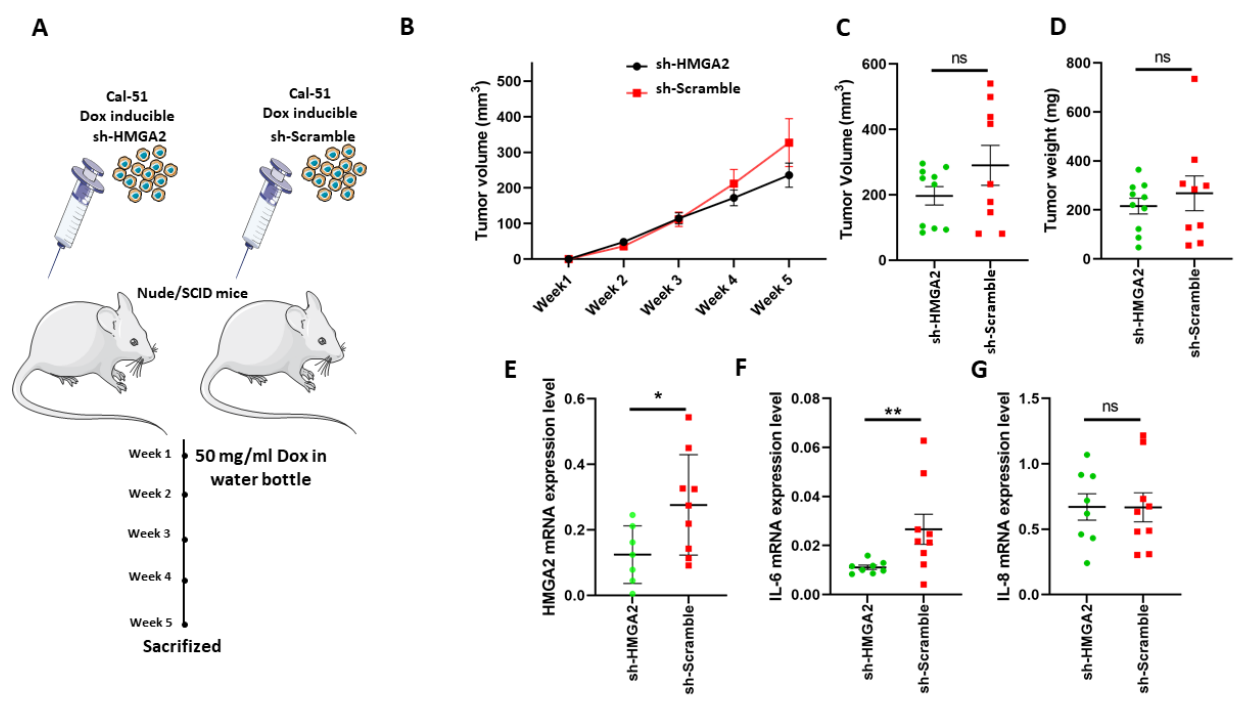
Figure 8. HMGA2 silencing decreased IL-6 expression in TNBC xenografts. Schematic illustration of an in vivo experiment with HMGA2 -silenced Cal-51 cells ( A ). Tumor volume was examined weekly ( B ). Tumor volume ( C ) and weight ( D ) after tumor extraction at week 5 were also determined. mRNA expression of HMGA2 ( E ), IL-6 ( F ) and IL-8 ( G ) was measured in tumors, showing significantly reduced HMGA2 and IL-6 levels in HMGA2 -silenced Cal-51 cells. The results are shown as mean ± SD ( n = 3) versus the shScramble group and statistical analysis was performed using the nonparametric Mann Whitney test. * p < 0.05, and ** p = 0.01.